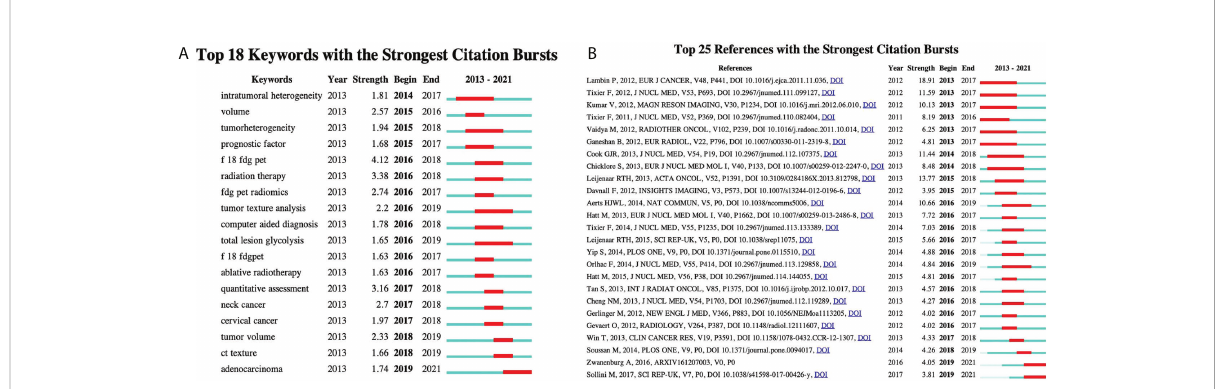
FIGURE 9 Detection of citation bursts. (A) Top 18 keywords with the strongest citation bursts. (B) Top 25 reference with the strongest citation bursts. Begin and end indicate the start time and end time of the mutation, respectively, and strength is the keyword mutation strength. The higher the strength, the greater the in fl